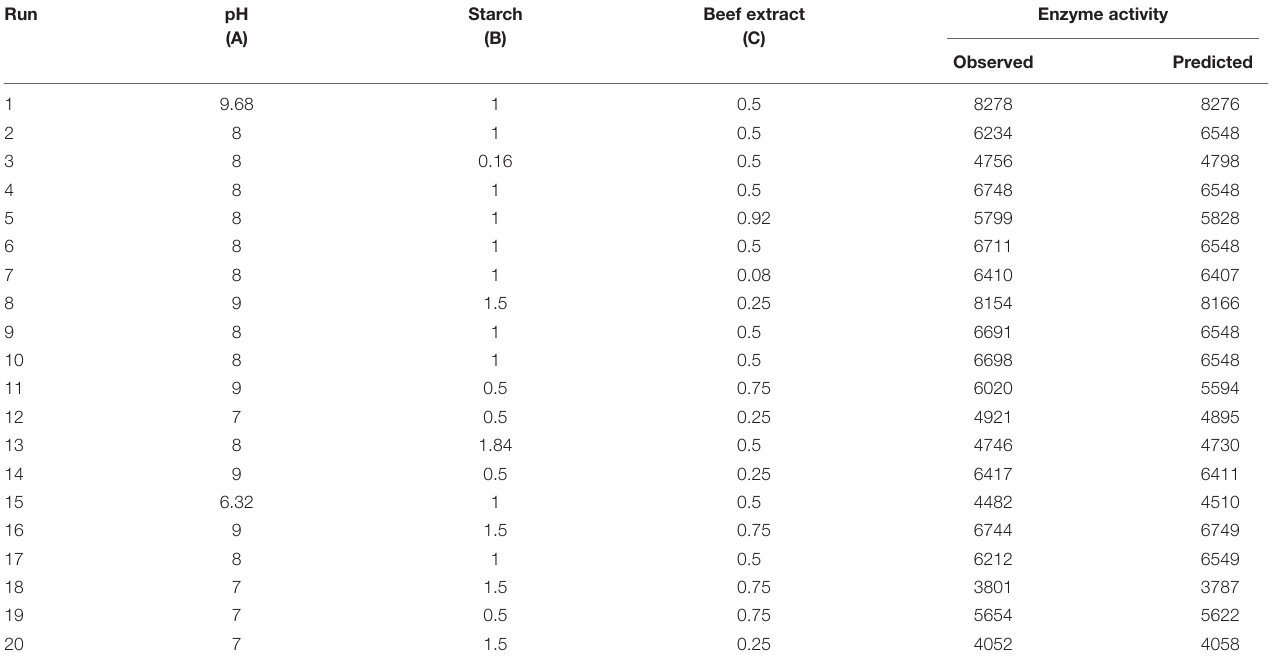
TABLE 3B | Actual and predicted values of fibrinolytic enzyme observed in experimental setup of response surface methodology. Run Enzyme activity